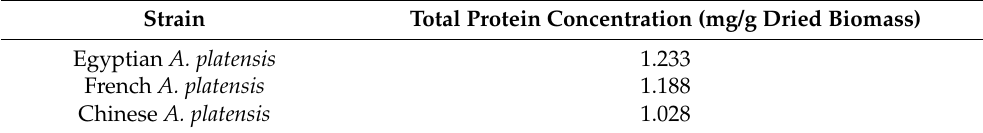
Table 1. The total protein content of the extracted C-phycocyanin from dried biomass of the three microalgae strains as measured by Bradford